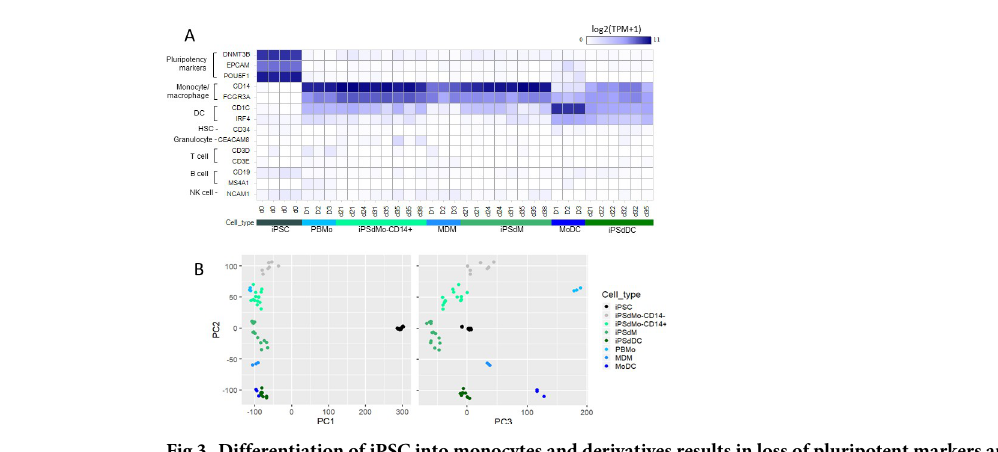
FCGR3A(CD16) as do the PBMo and MDM (Fig 3A). iPSdDC and MoDC express CD1C and